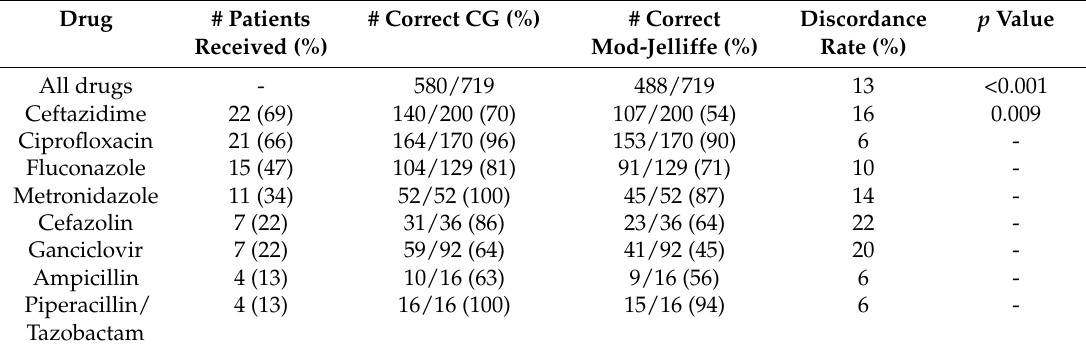
Table 5. Dose appropriateness for specific antimicrobials.